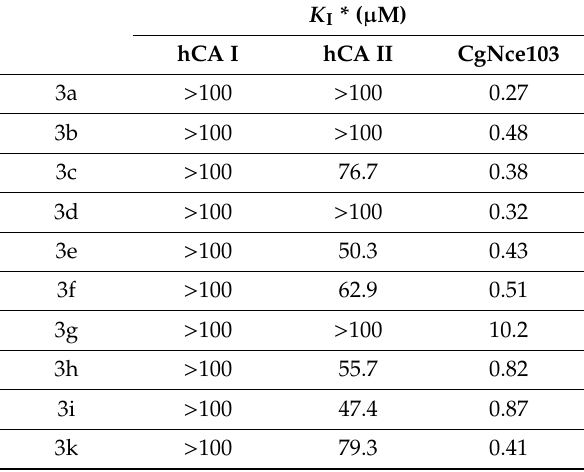
Table 2. Inhibition data of selected human and fungal CA isoforms (hCA I, hCA II, and CgNce103) by the most promising thiazolidinone compounds and the standard sulfonamide inhibitor acetazolamide (AAZ) by a stopped-flow CO 2 hydrase